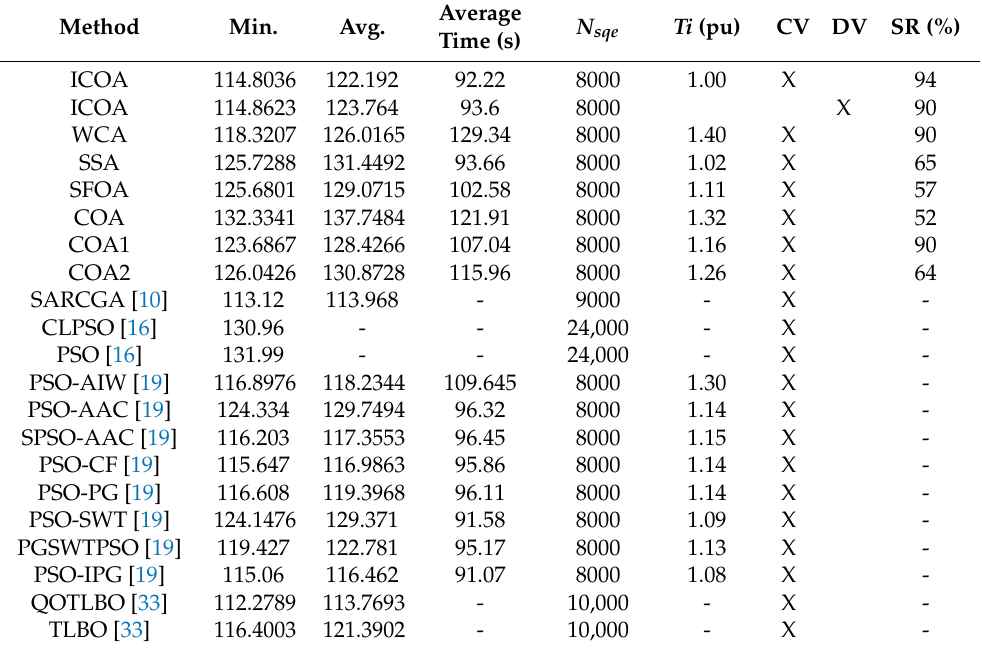
Table 11. Comparison of results obtained from the IEEE 118-bus system with power-loss optimization.